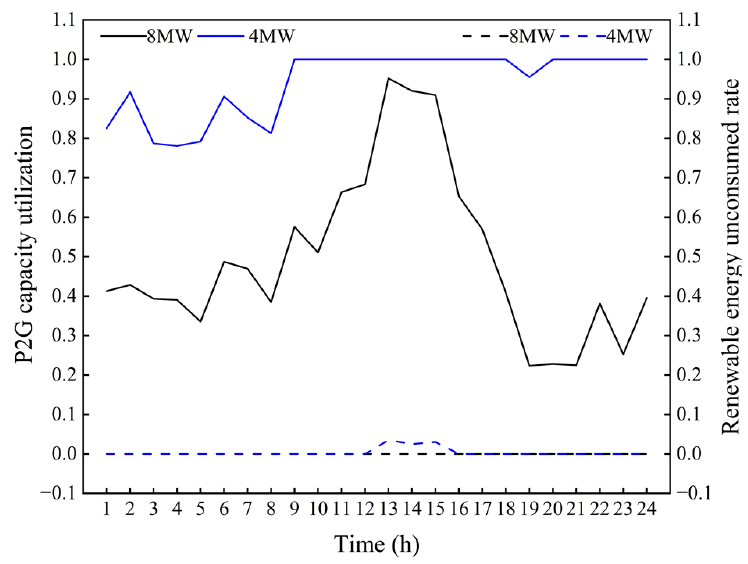
Figure 14. P2G utilization and dissipation in PIES 1 for scenario 4.